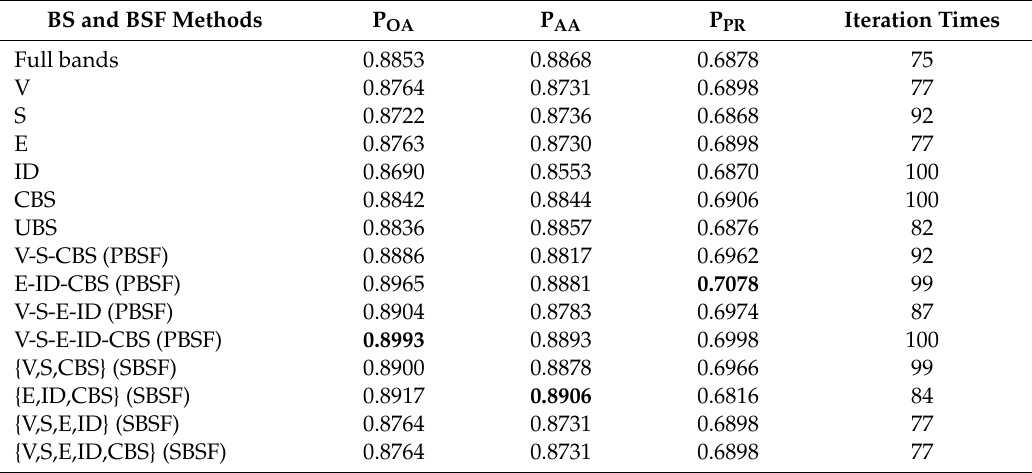
Table A4. P OA , P AA , P PR and the number of iterations calculated by ICEM using full bands and bands selected in Table 7 for the University of Pavia